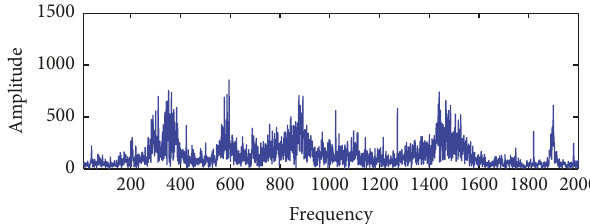
Figure 9: The FT of the vibration signal obtained from the normal gear.